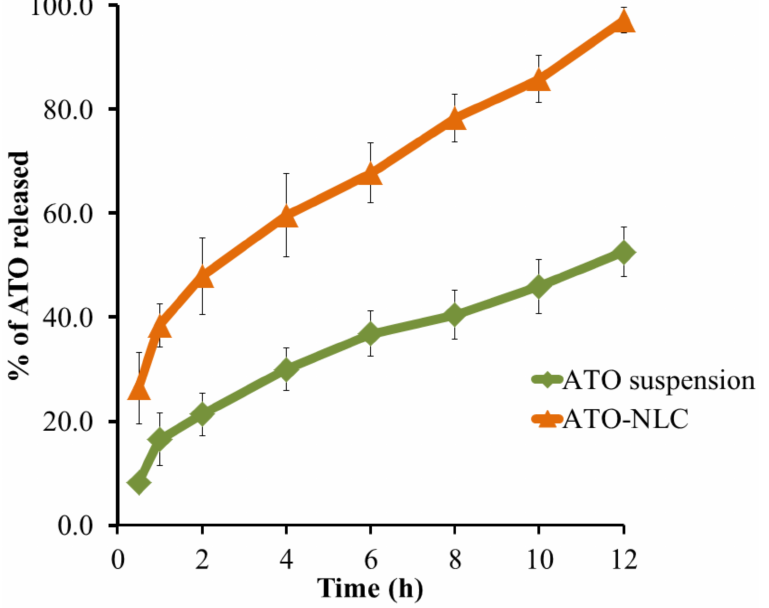
Figure 8. Outline of ATO in vitro release from optimized NLC formulations and